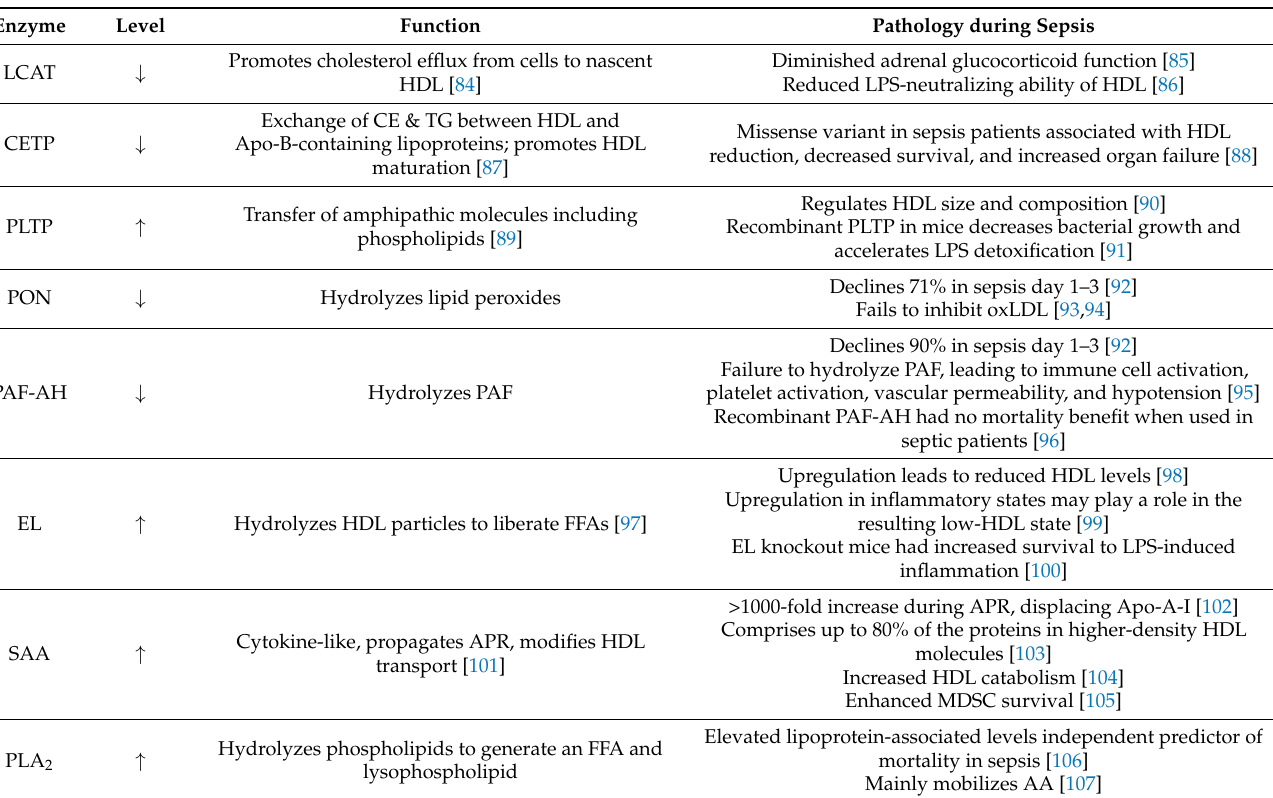
Table 1. Mechanisms of HDL dysfunction during sepsis by alterations in HDL-associated